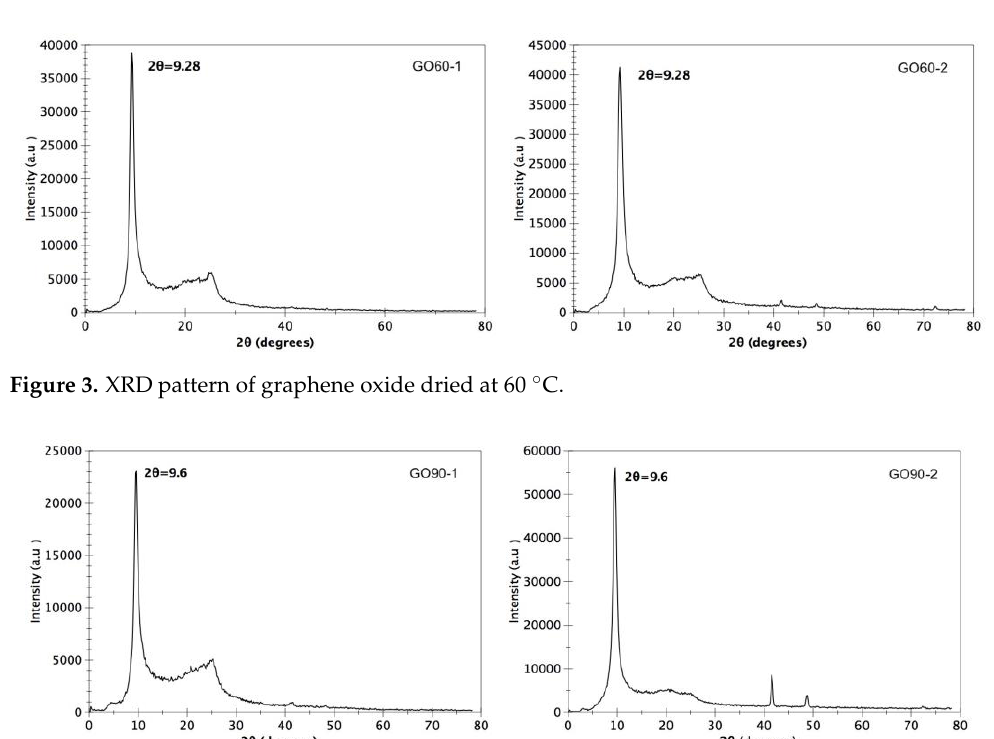
Figure 4. XRD pattern of graphene oxide dried at 90 °C.